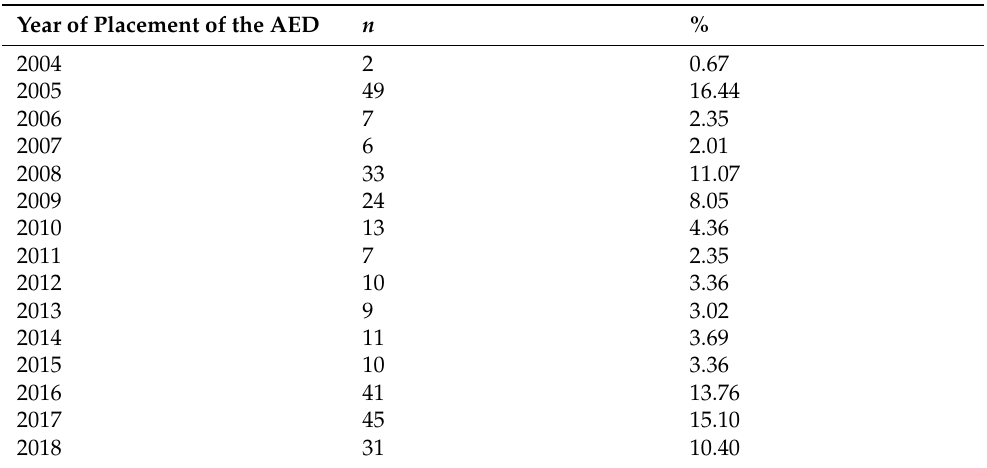
Table 1. The year of installation of the AED at the location.